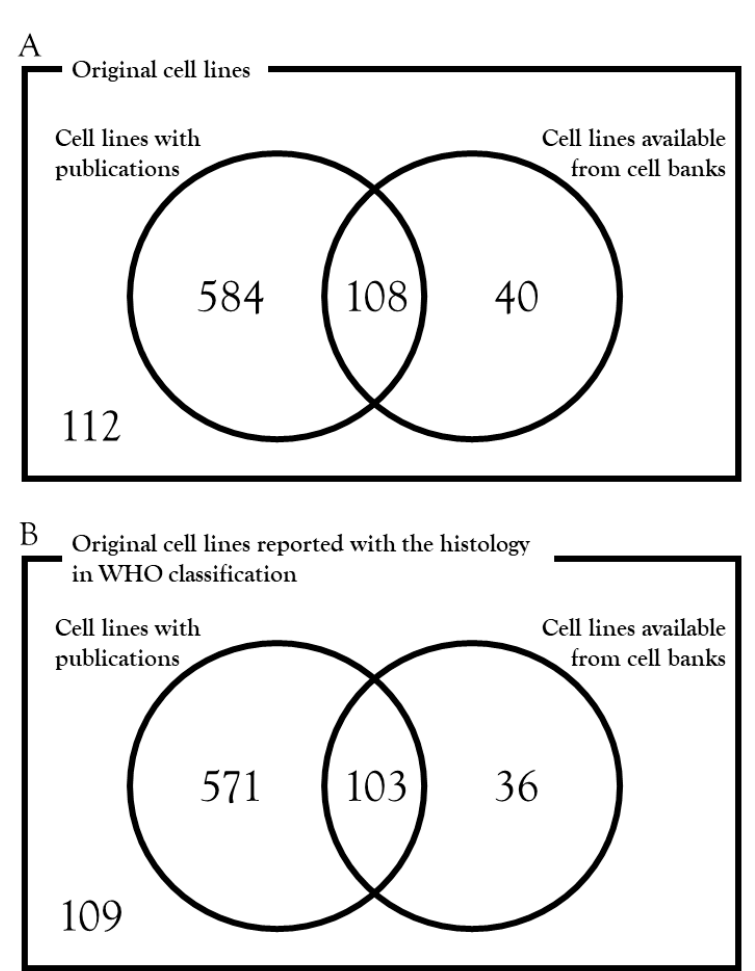
Figure 2. The number of cell lines that were reported in publications or available from cell banks. ( A ) Note that among the 844 original cell lines, 112 cell lines were neither published nor available from cell banks. ( B ) Note that among the 819 original cell lines with the histology defined by WHO classification, 109 cell lines were neither published nor available from cell banks.